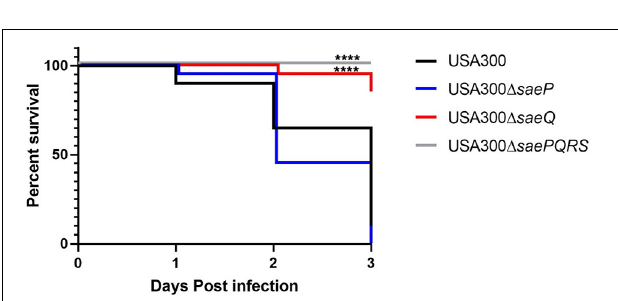
FIGURE 4 | saeQ contributes to staphylococcal disease during bacteremia. Groups of 10 C57BL/6 mice were infected intravenously via the tail vein with 1 × 10 7 CFU of the indicated S. aureus strains. Survival curves are from two independent experiments **** P < 0.0001, log-rank (Mantel-Cox)